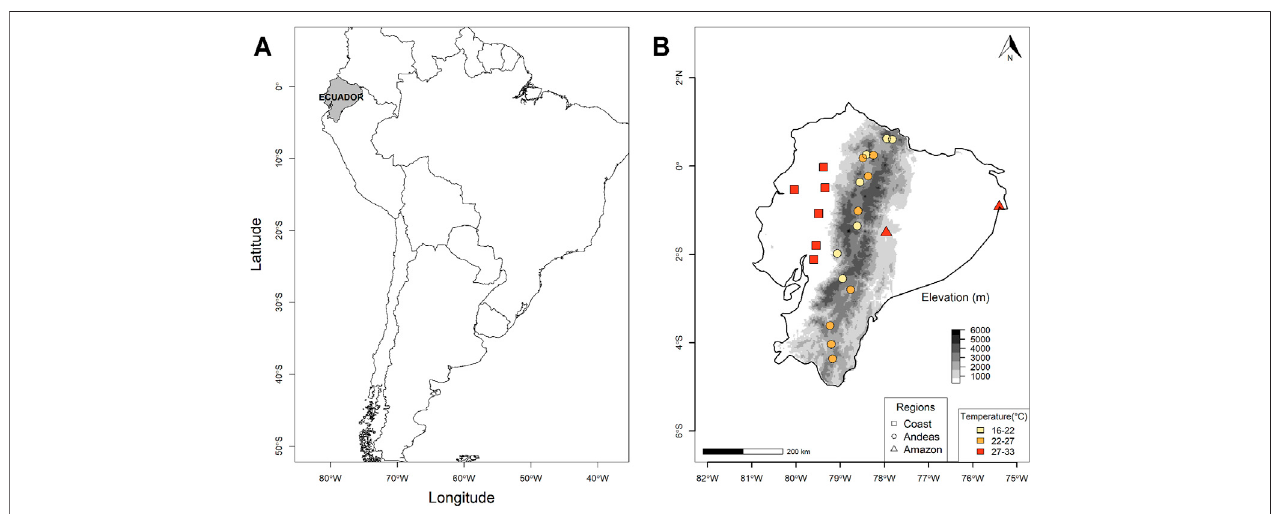
FIGURE 1 | (A) Location of Ecuador in South America and (B) location of temperature gauges; shape of labels denotes different climate zones (square, Coast; circle, Andes; triangle, Amazon), and it shows the 84th percentile of daily maximum temperature (P84Tmax) in Ecuador from the historical period (1981 – 2005); temperature is expressed in degrees